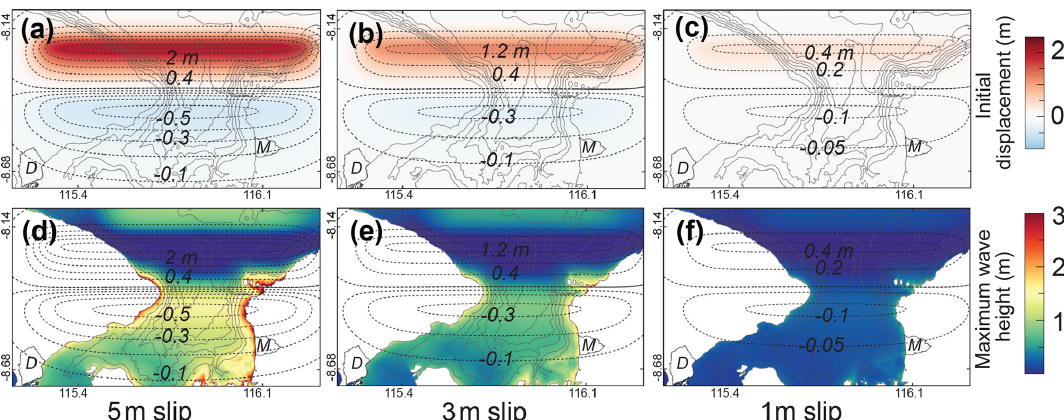
Figure 8. Initial surface deformation and maximum wave heights in 1h generated by different slip amounts on the upper half of the fault ramp (model B). (a–c) The coseismic deformation generated by (a) 5m, (b) 3m, and (c) 1m fault slip events results in a narrow uplift patch in the north and broader subsidence in the south. (d–f) Maximum sea surface displacements for (d) 5m, (e) 3m, and (f) 1m fault slip events. Maps are adjusted to show wave heights relative to the post-earthquake land surface rather than initial sea level by subtracting the coseismic displacement (dashed contour lines). The highest waves are concentrated around the headlands of Lombok and Bali at 8.38 ◦ S and the mid-west coast of Lombok. Polygons on land – cities of Denpasar, Bali, and Mataram, Lombok. D denotes Denpasar; M denotes